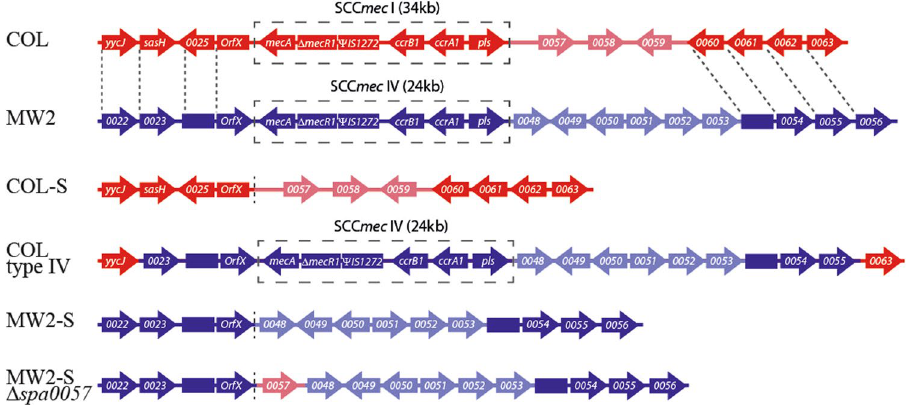
Figure 1. Schematic representation of S. aureus strains with SCC mec types I and IV. The SCC mec element and surrounding regions of strains COL, MW2, COL type IV, COL-S, MW2-S and MW2-S Δ spa 0057 are graphically represented here. Annotated ORFs are shown as arrows and non-annotated homologous regions are represented as boxes. The SACOL ORFs are colored in red, the MW ORFs are in blue and the SCC mec element is highlighted by a black box (not all SCC mec genes are shown). Homologous regions of COL and MW2 genomes are shown in dark colors and indicated by dotted lines, while non-homologous regions are in light colors. Next generation sequencing of COL type IV indicates a double crossover event occurring downstream of yycJ ( mw0022 homologue) and upstream of sacol0063 ( mw0056 homologue). Not to scale.